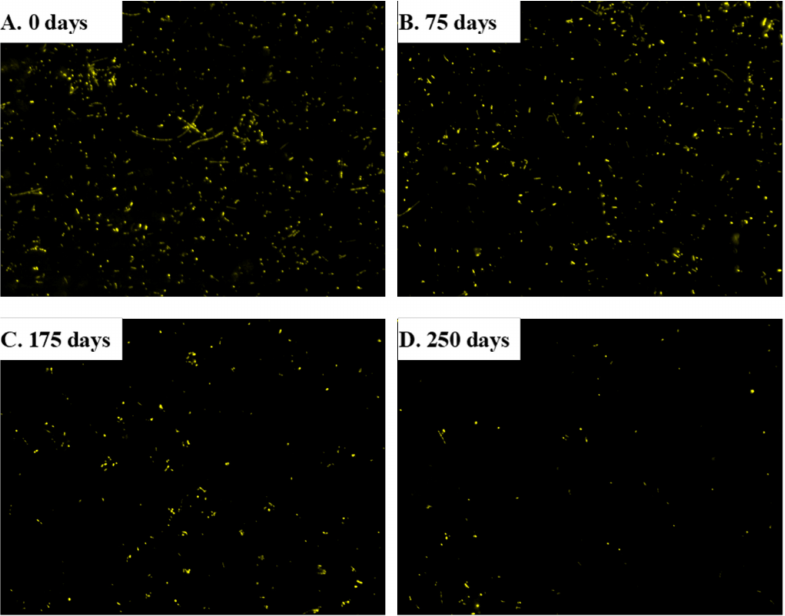
Figure 6. DAPI stained images for the determination of bacterial abundance at distinct experimental times.